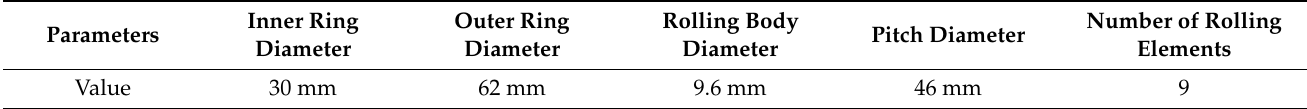
Table 3. The basic parameters of deep groove ball